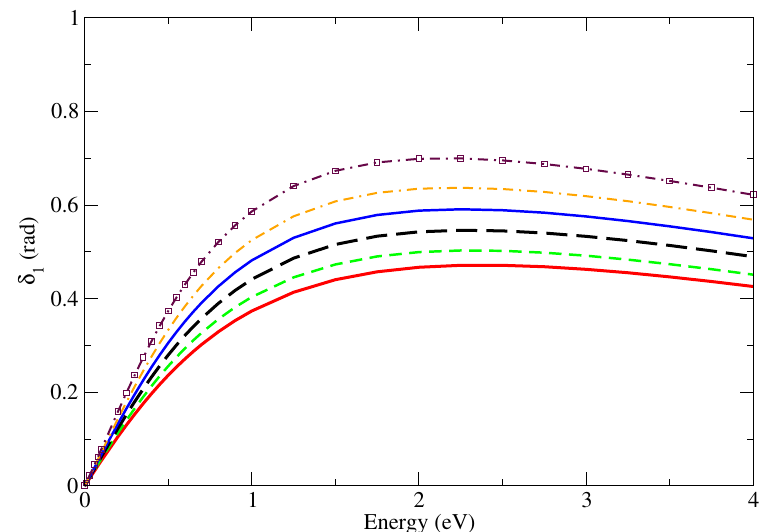
Figure 4. The same as Figure 3, but for the p wave. Note that no shape resonance is found for any value of α d . The legends are the